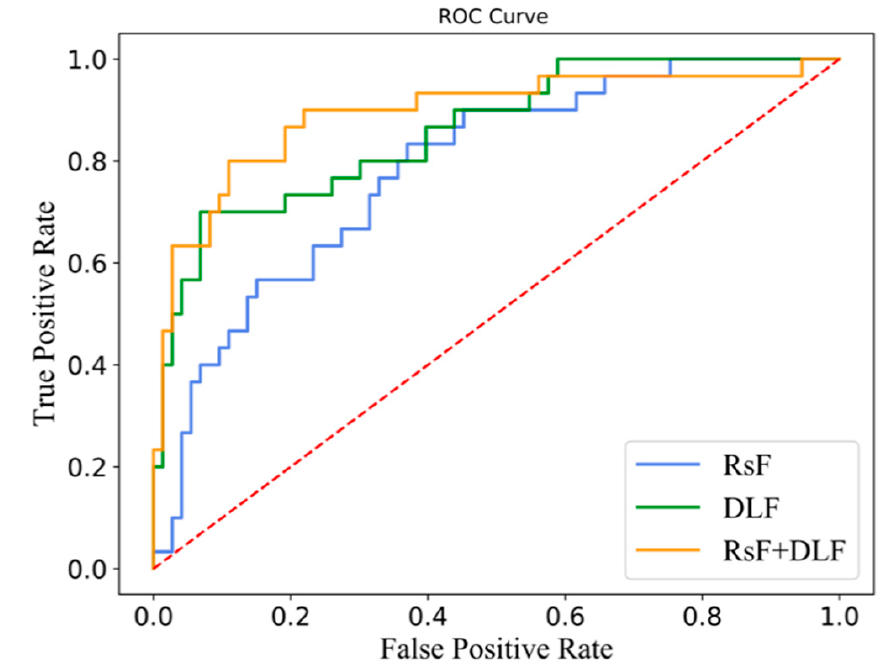
Figure 4. ROC curves of the prediction models. Table 5. The performance of radiomics-based model, deep learning-based model and integrated model on 5-Fold cross validation.